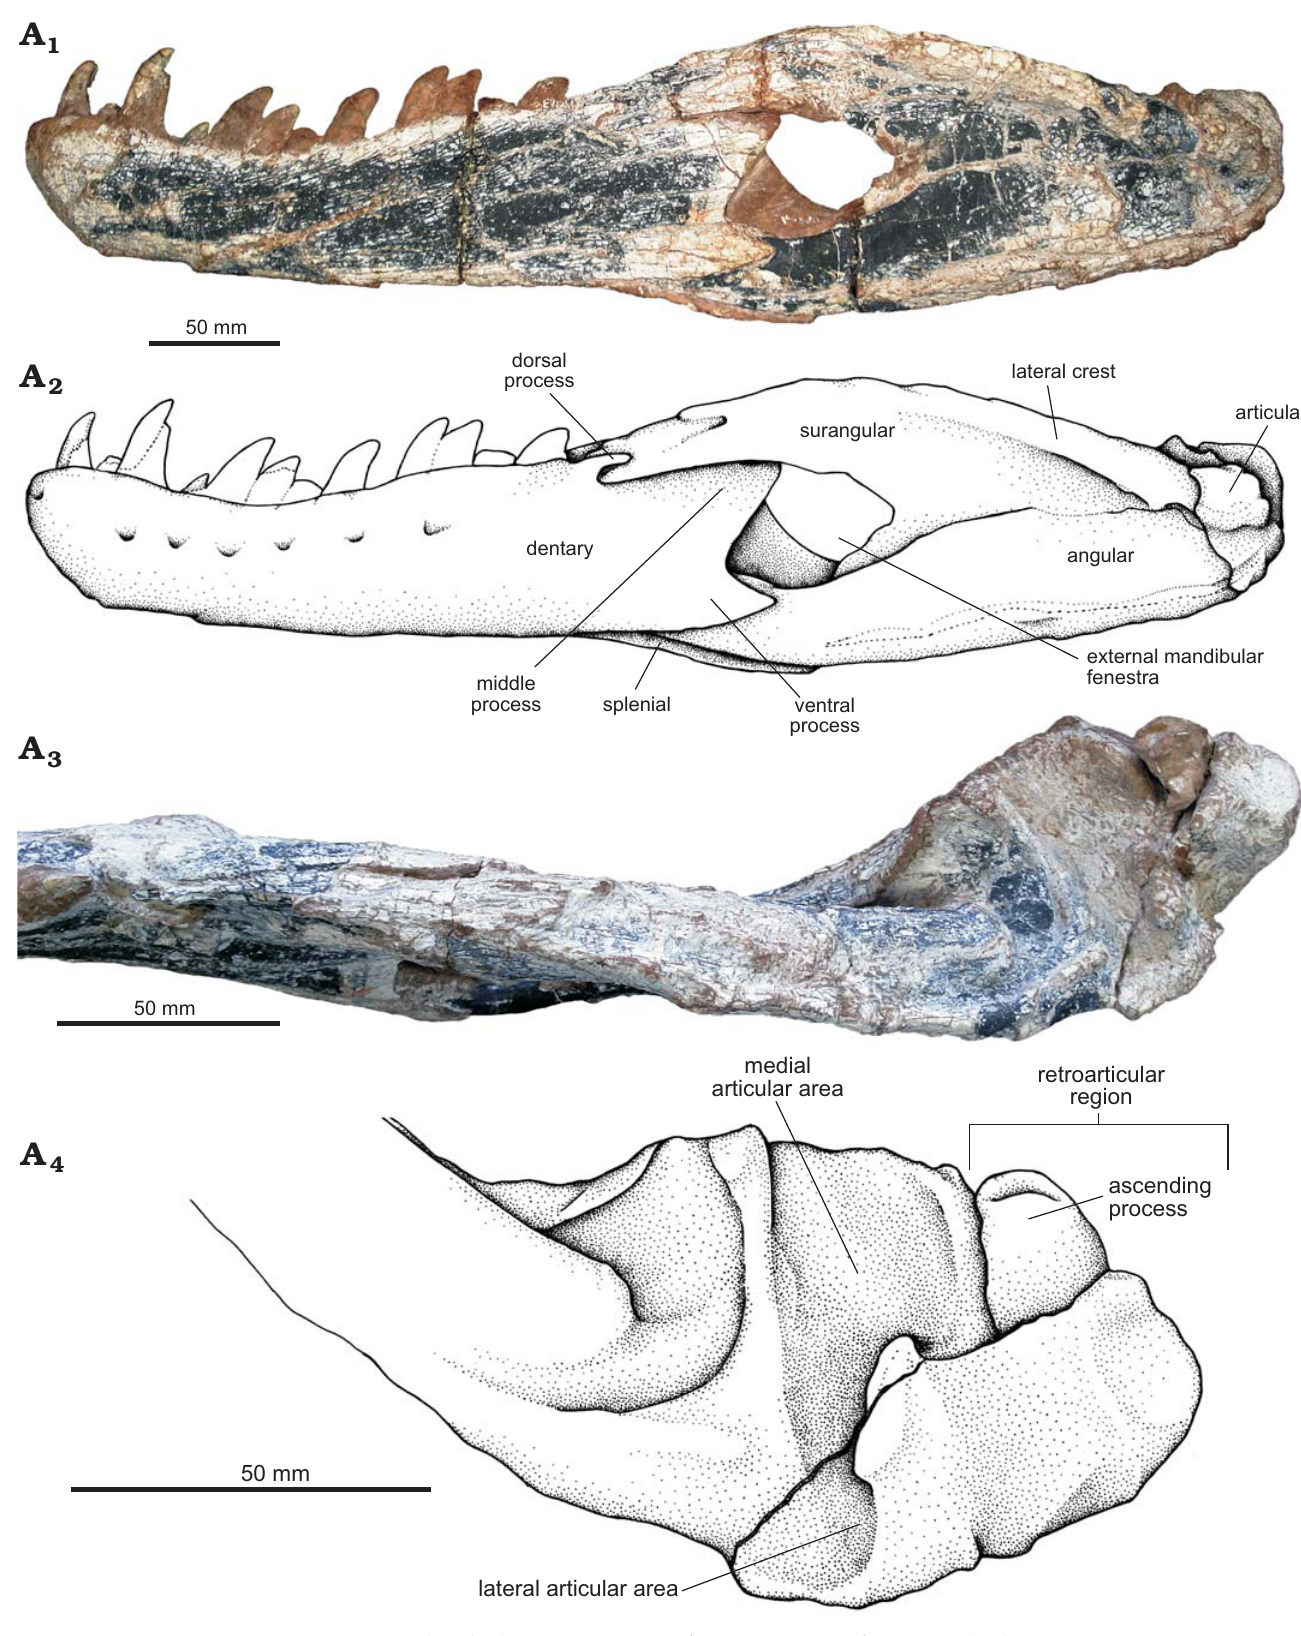
Fig. 18. The pseudosuchian archosaur Prestosuchus chiniquensis Huene, 1938 (UFRGS-PV-0629-T) from the Dinodontosaurus Assemblage Zone, Ladi- nian, Middle Triassic, Dona Francisca municipality, Rio Grande do Sul State, Brazil. Left mandible of in lateral view (A 1 , A 2 ). Detail of the articular and retroarticular areas in dorsal view (A 3 , A 4 ). Photographs (A 1 , A 3 ) and explanatory drawings (A 2 , A 4